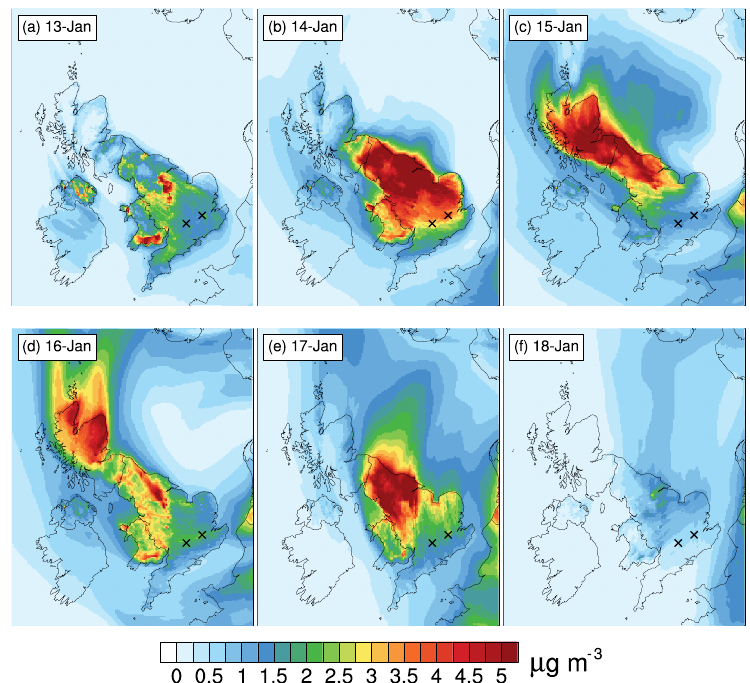
Figure 9. Daily average modelled ( Base4x experiment) SFOA surface concentrations during the episode of high SFOA concentrations at the beginning of the winter IOP, year 2012. The black crosses mark the measurement site locations, left: Harwell, right: London North Kensington.